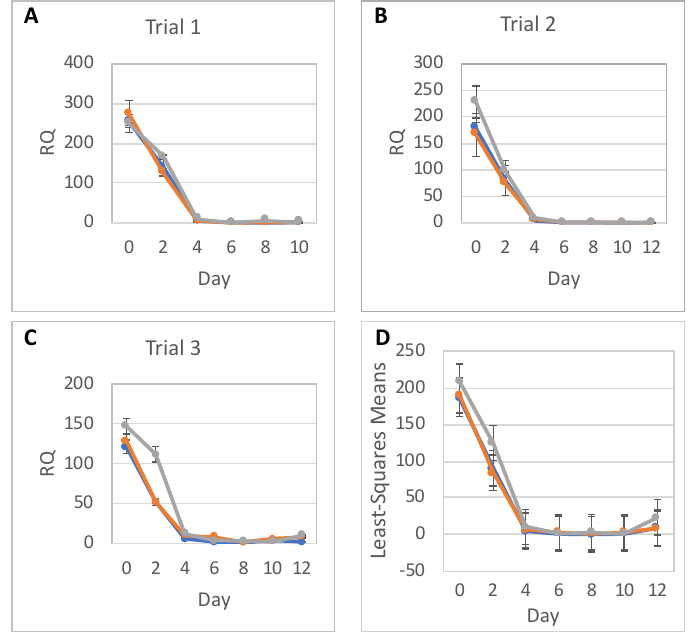
Figure 5. OCT4 gene expression. OCT4 relative to TBP RNA expression (RQ) in hESCs during their differentiation into NPCs in three independent trials ( A – C ) in 0-dose (blue), low-dose (orange), and high-dose (grey) samples; error bars show standard deviations of experimental measurements. ( D ) Statistical analysis of OCT4 expression data; error bars show 95% confidence limits for the least square means of OCT4 RQs in 0-dose (blue), low-dose (orange), and high-dose (grey) samples from all trials and with replicates combined. Table 5. Difference between 0-dose and low-dose groups in least square means of OCT4 RNA expression according to day.